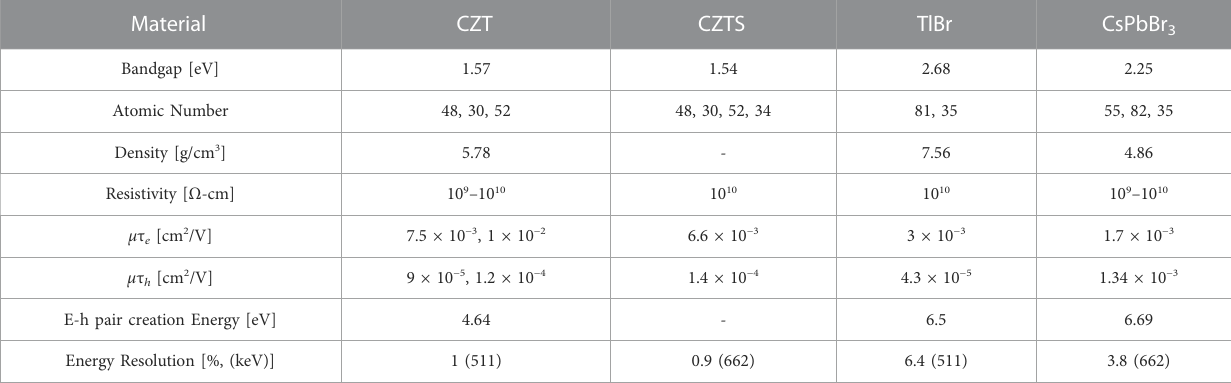
TABLE 2 Material properties for various semiconductor materials for radiation detection [37, 49 – 55].